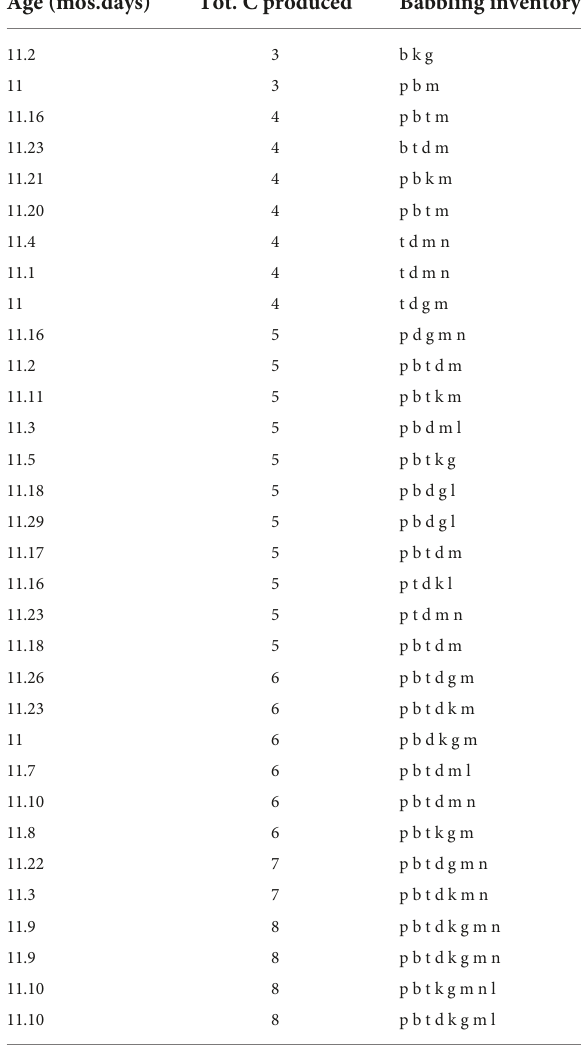
TABLE 3 Experiment 1: quantity and type of consonant produced (parental questionnaires. 11-month-olds). Age